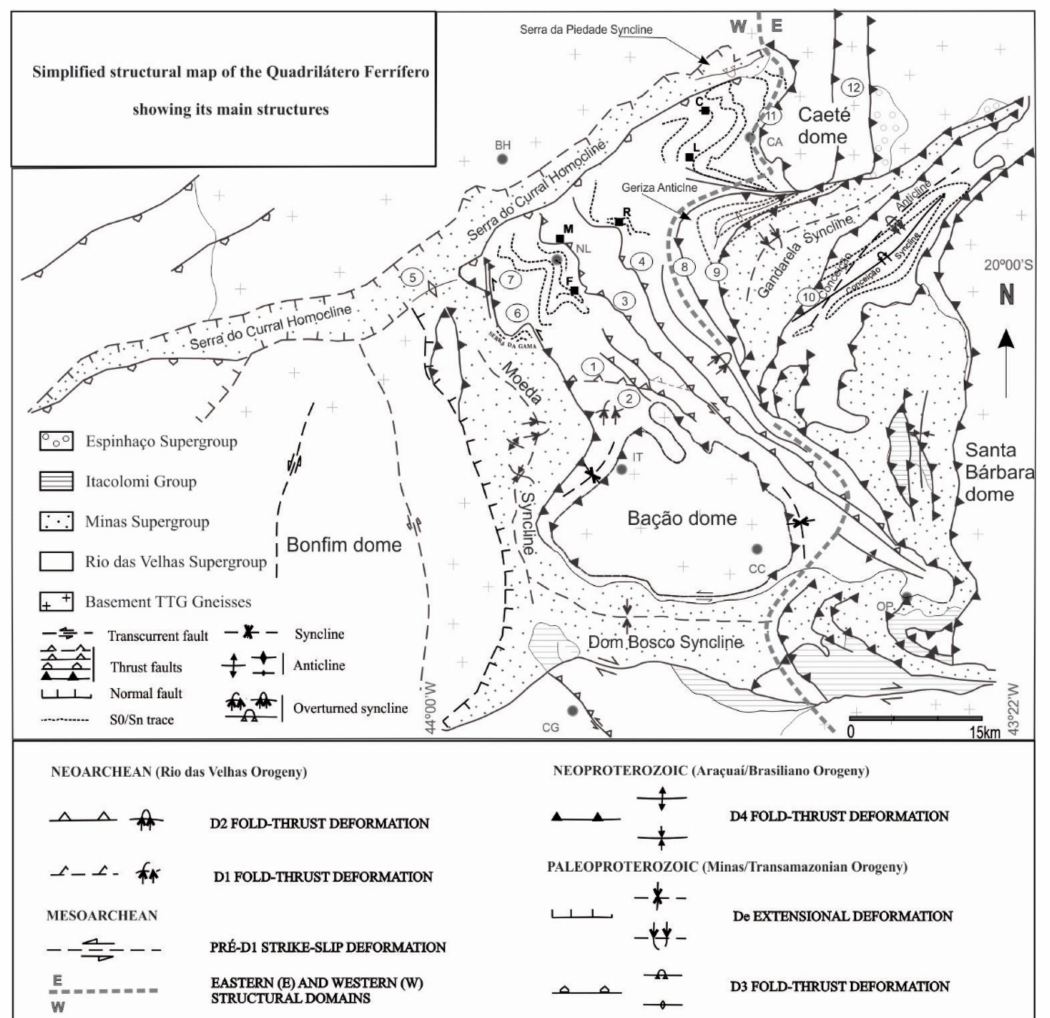
Figure 4. Structural map of the Quadril á tero Ferr í fero showing the main structures of the Rio das Velhas greenstone belt (modified after [6,23,30]). Megastructures include (i) shear zones: 1—Bem-Te-Vi; 3—S ã